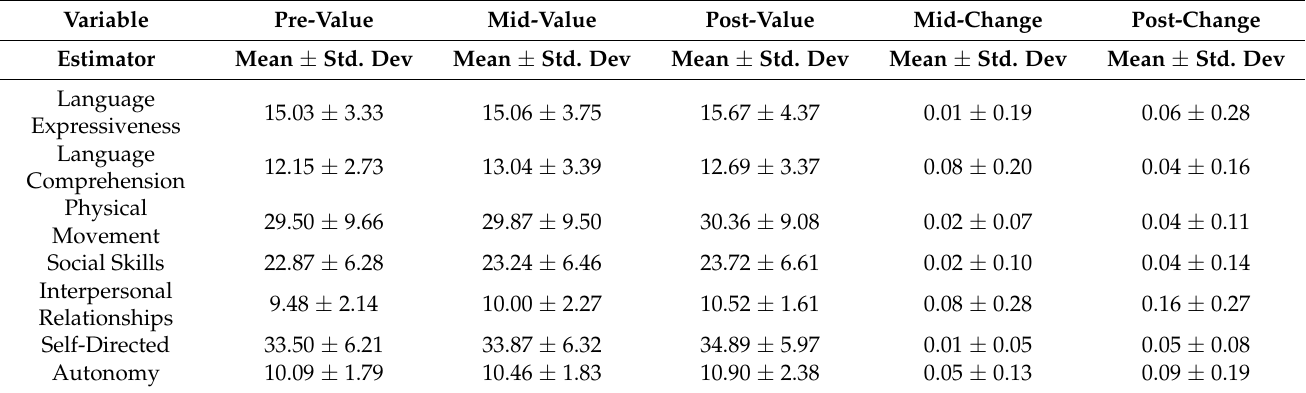
Table 2. The measured variables for the descriptive statistics